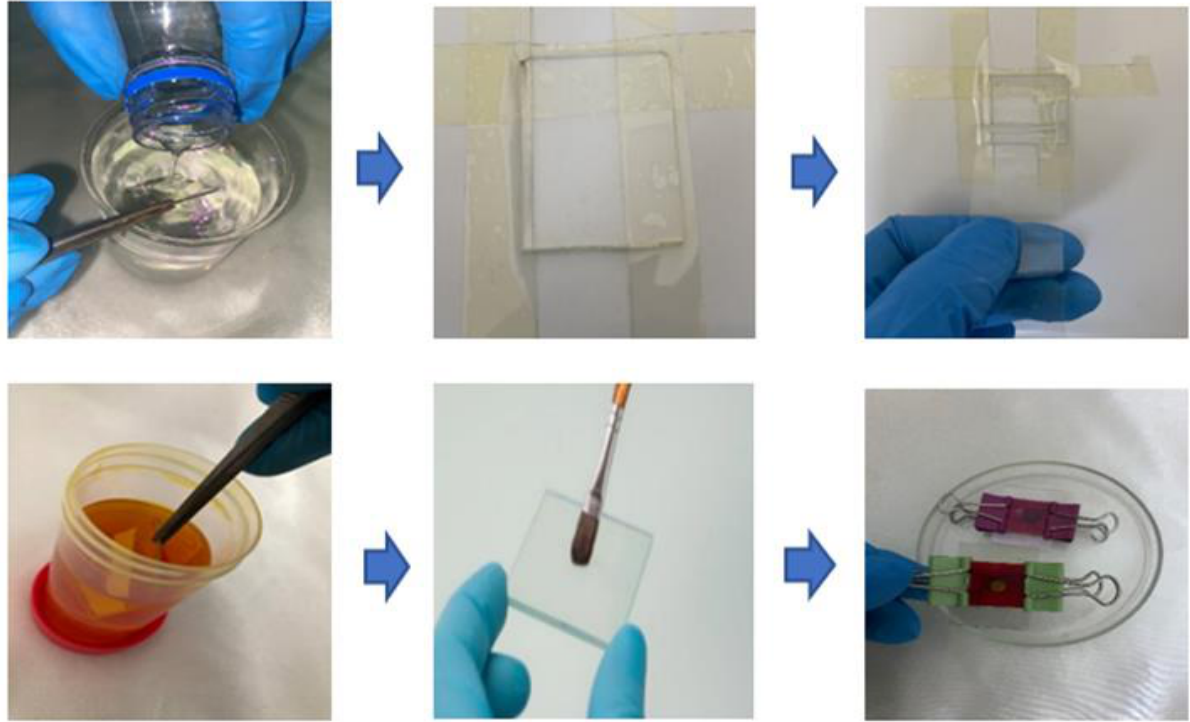
Figure 3. Photographs of DSSCs fabrication stages .